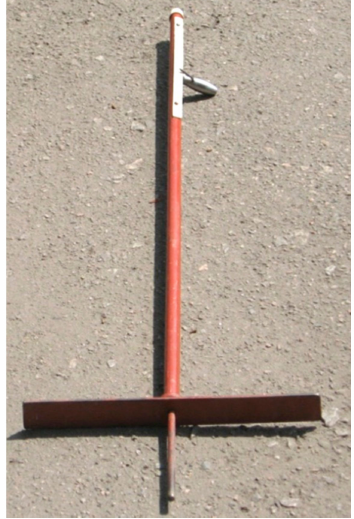
Figure 6. Instrument for measuring tillage